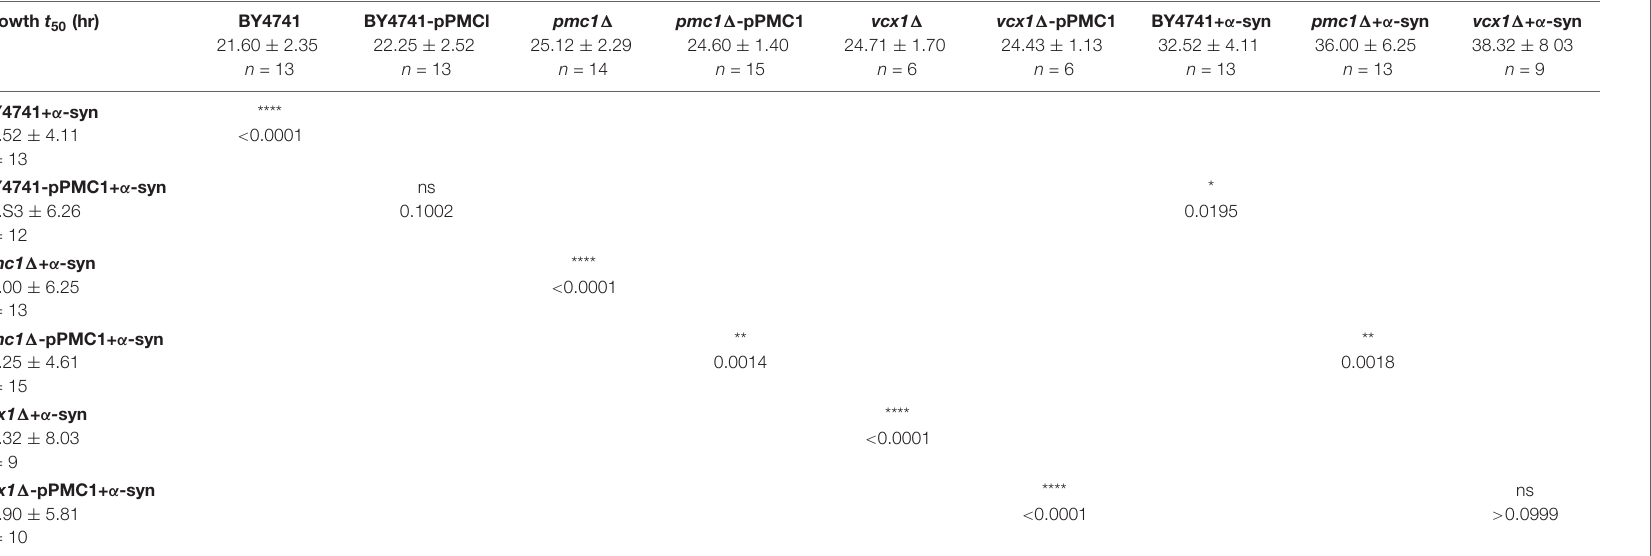
BY4741-pPMCl 21.60 ± 2.35 22.25 ± 2.52 n = 13 n = 13 **** < 0.0001 ns 0.1002